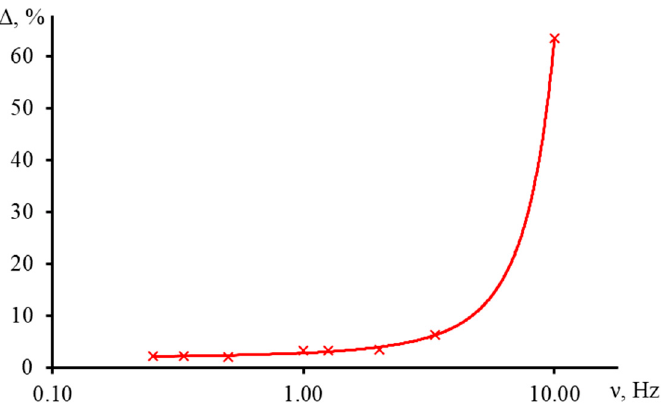
Figure 18. Measurement error of the characteristic time on the modulation frequency of an aqueous solution of ferroin (2.5 µ mol/L); narrow-focused configuration ( ω e 0 = 33 µ m, Figure 1, Table 3).